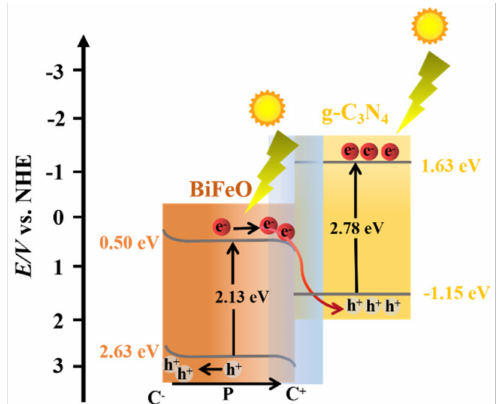
Figure 14. Schematic illustration of the charge-carrier migration mechanism of Z-scheme heterojunc- tion for 10BiFeO/g-C 3 N 4